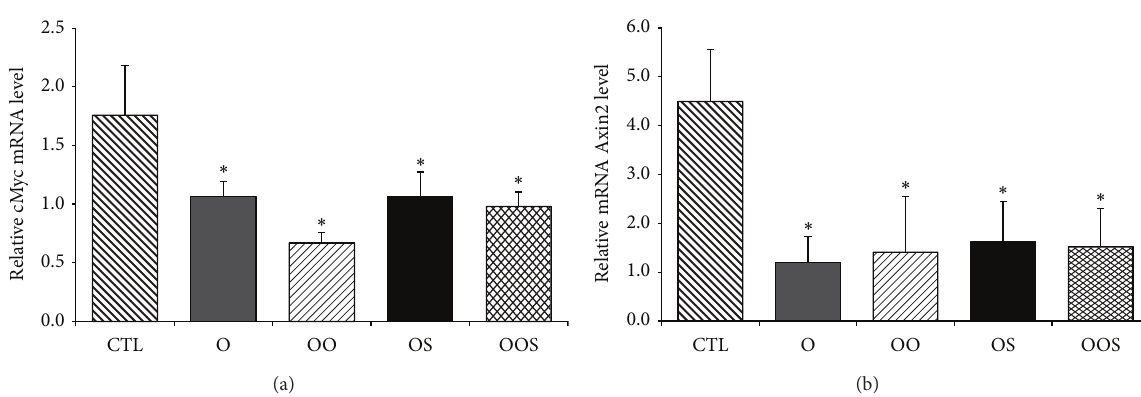
Figure 2: Expression of (a) cMyc and (b) Axin2 in osteoblasts grown as described in Figure 1. Differences were considered significantly different when a 𝑃 < 0.05 was obtained ∗ 𝑃 < 0.05 versus CTL; § 𝑃 < 0.05 versus O.